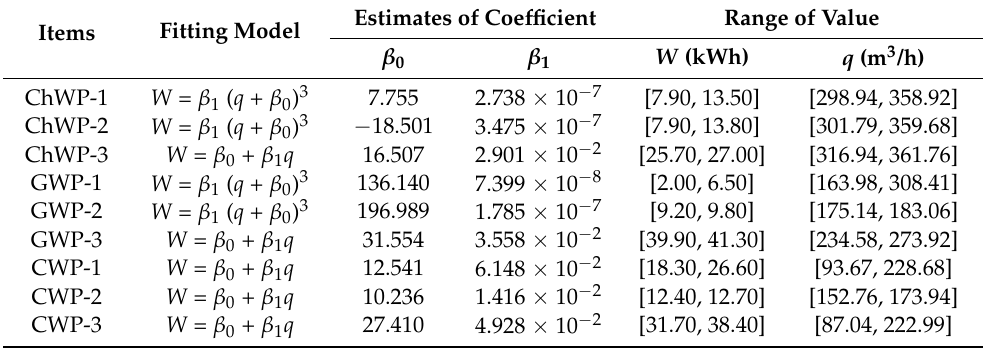
Table 4. Fitting results of energy-consumption and flow rate of the nine pumps in the case system.